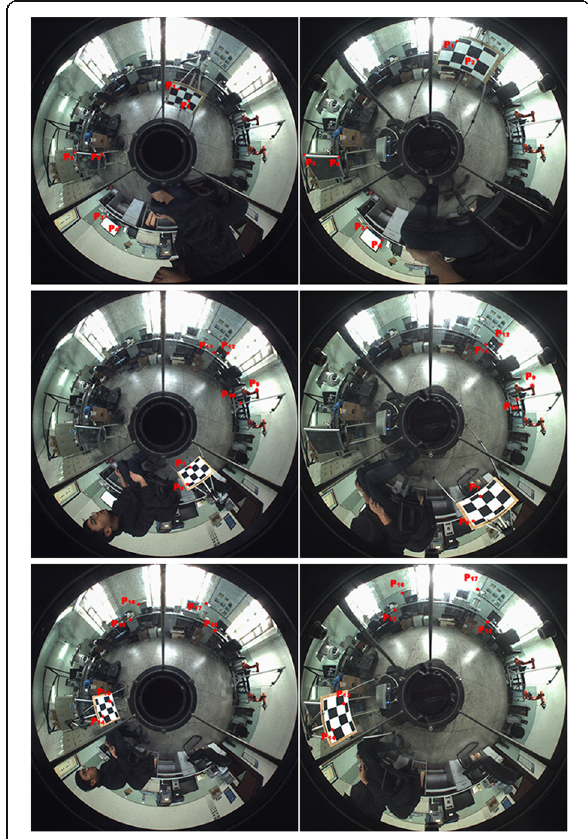
Fig. 14 Three stereo pairs and selected points used for depth estimation